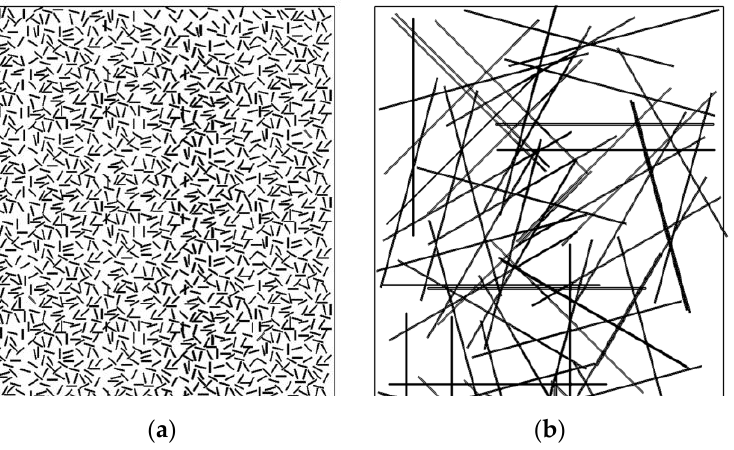
Figure 14. A schematic diagram of the distribution of SCFs with lengths of 100 ( a ) and 2000 ( b )